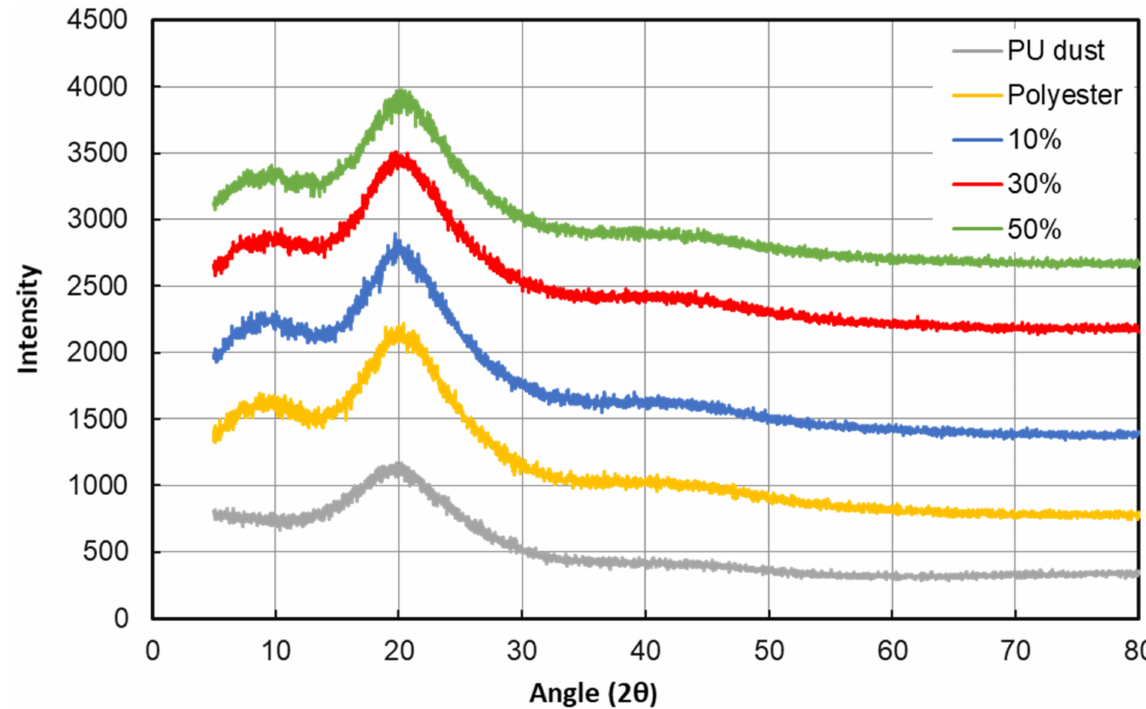
Figure 4. XRD analysis for pure polyester, PU dust, 10-PUD, 30-PUD and 50-PUD